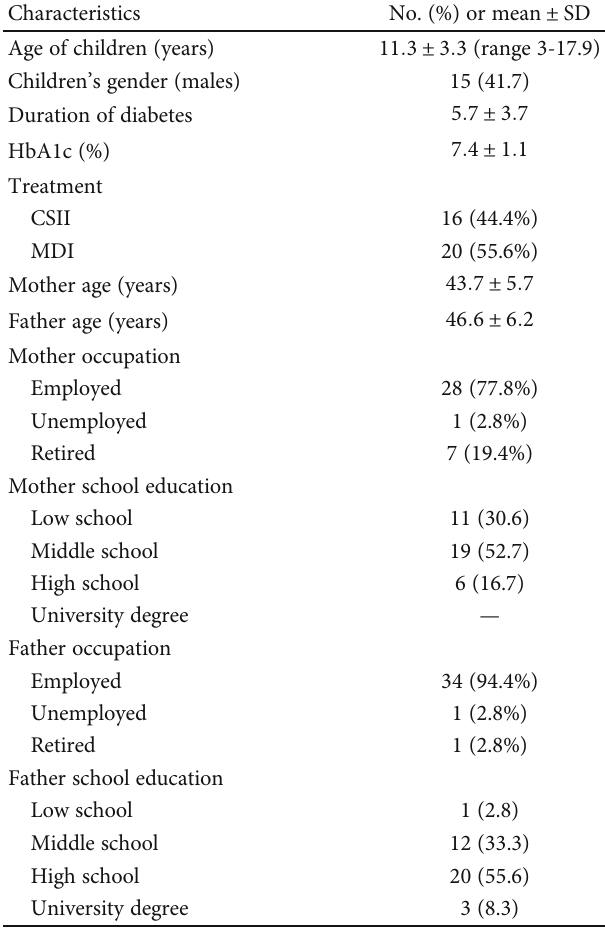
Table 1: Characteristics of children/adolescents and their parents.